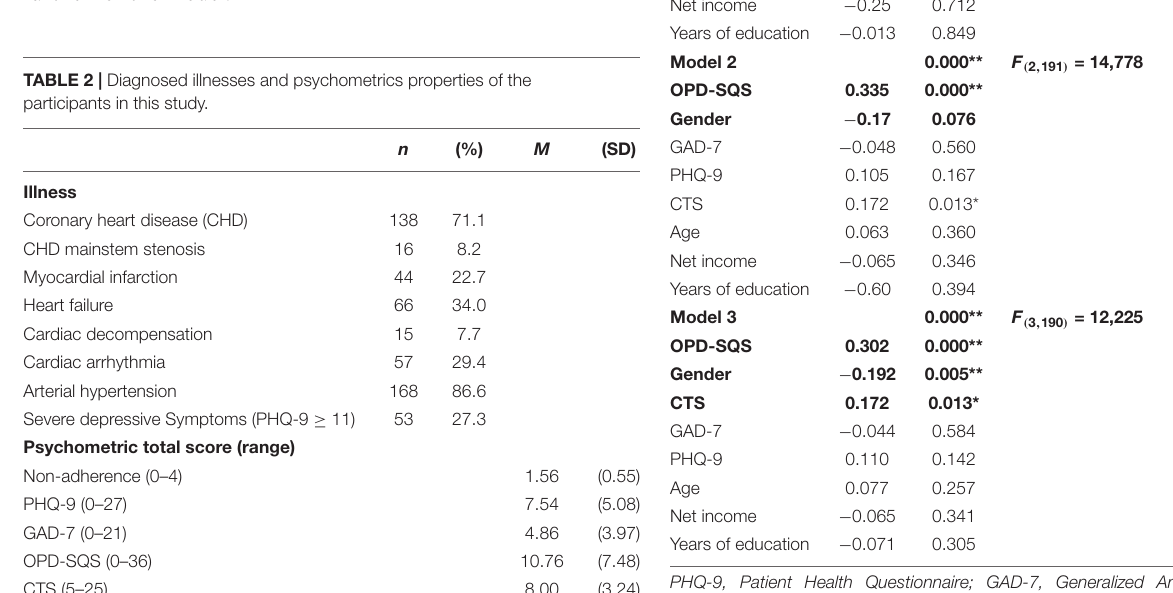
0.305 PHQ-9, Patient Health Questionnaire; GAD-7, Generalized Anxiety Disorder Scale-7; OPD-SQS, OPD Structure Questionnaire; CTS, Childhood Trauma Screener. b = Standardized regression coefficient; R 2 adj = adjusted R-squared; (cid:49) R 2 = difference in the proportion of variance explained. Bold variables indicate inclusion in the model. N = 194, *p < 0.01, **p <